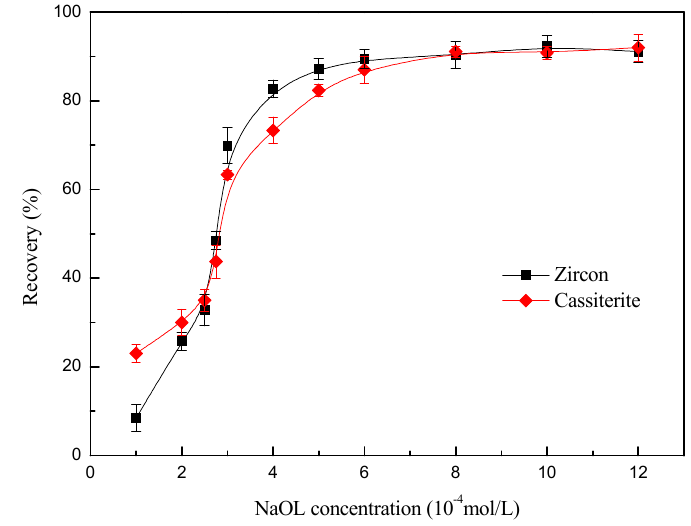
Figure 5. Flotation recoveries of zircon and cassiterite as a function of NaOL concentration (pH = 8).